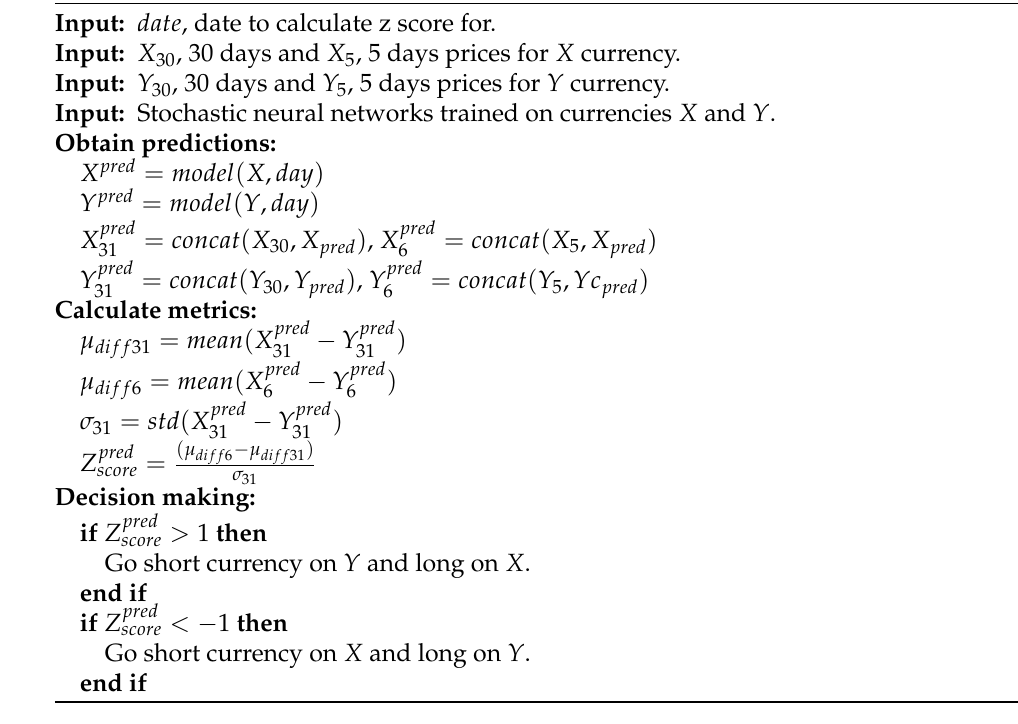
Algorithm 3 Pairs trading using stochastic neural networks.